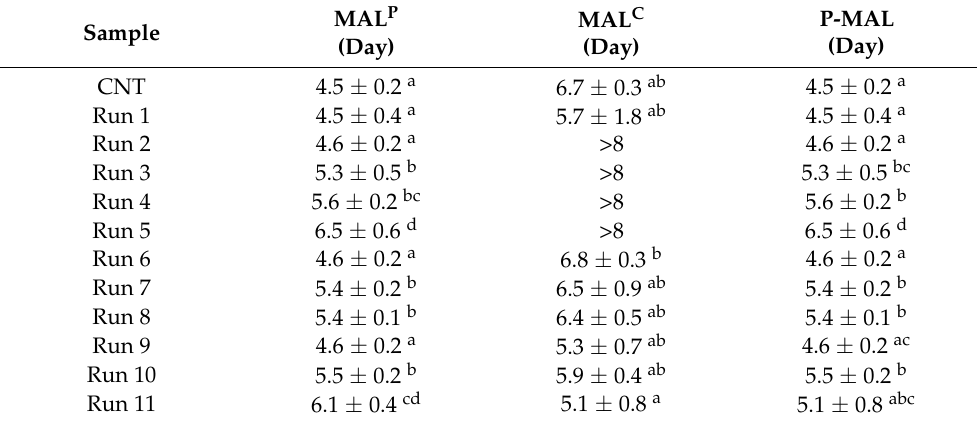
Table 2. Microbial acceptability limit (MAL) values relative to Pseudomonas spp. (MAL P ) and coliforms (MAL C ) of each investigated run. P-MAL is the lowest value between MAL P and MAL C and it is considered the MAL value of the entire